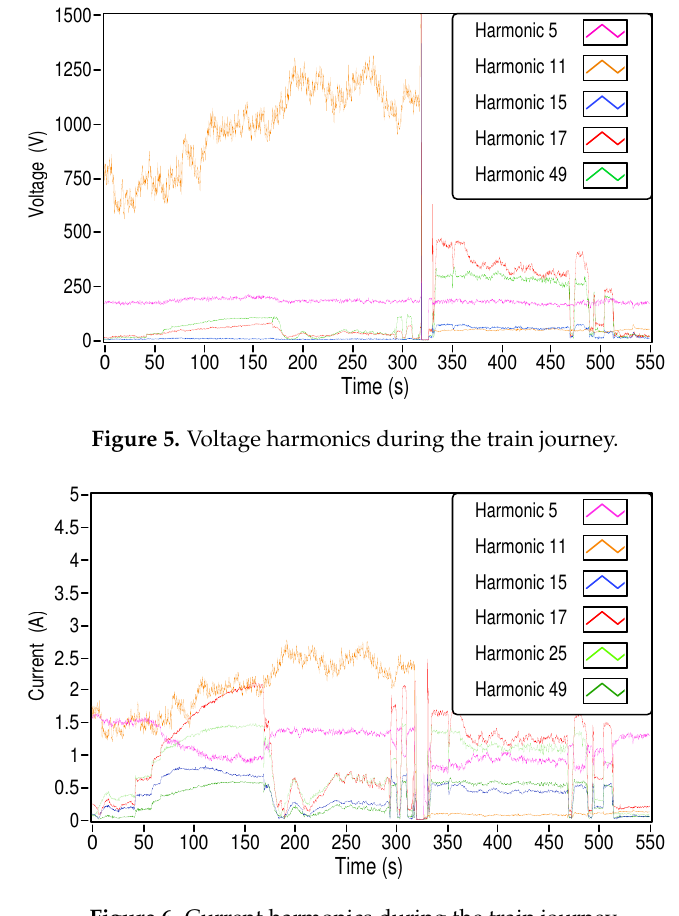
Figure 6. Current harmonics during the train